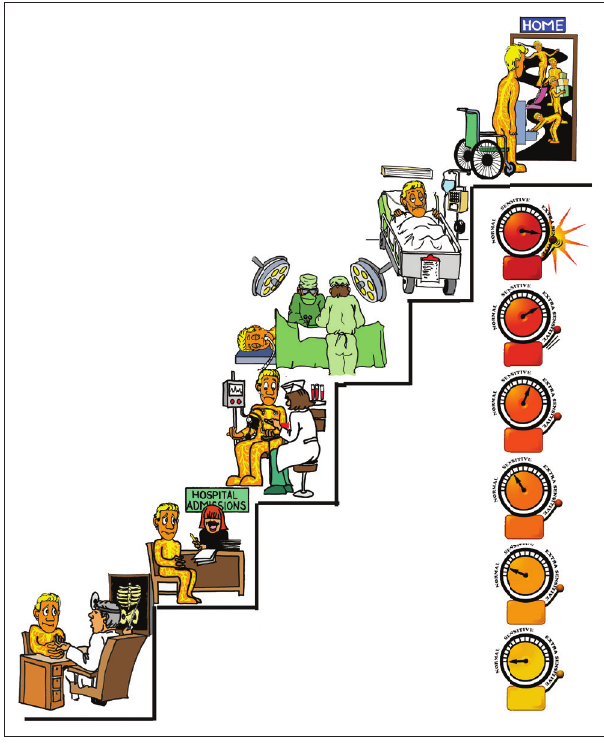
FIGURE 2: Example of picture to explain ‘hospital